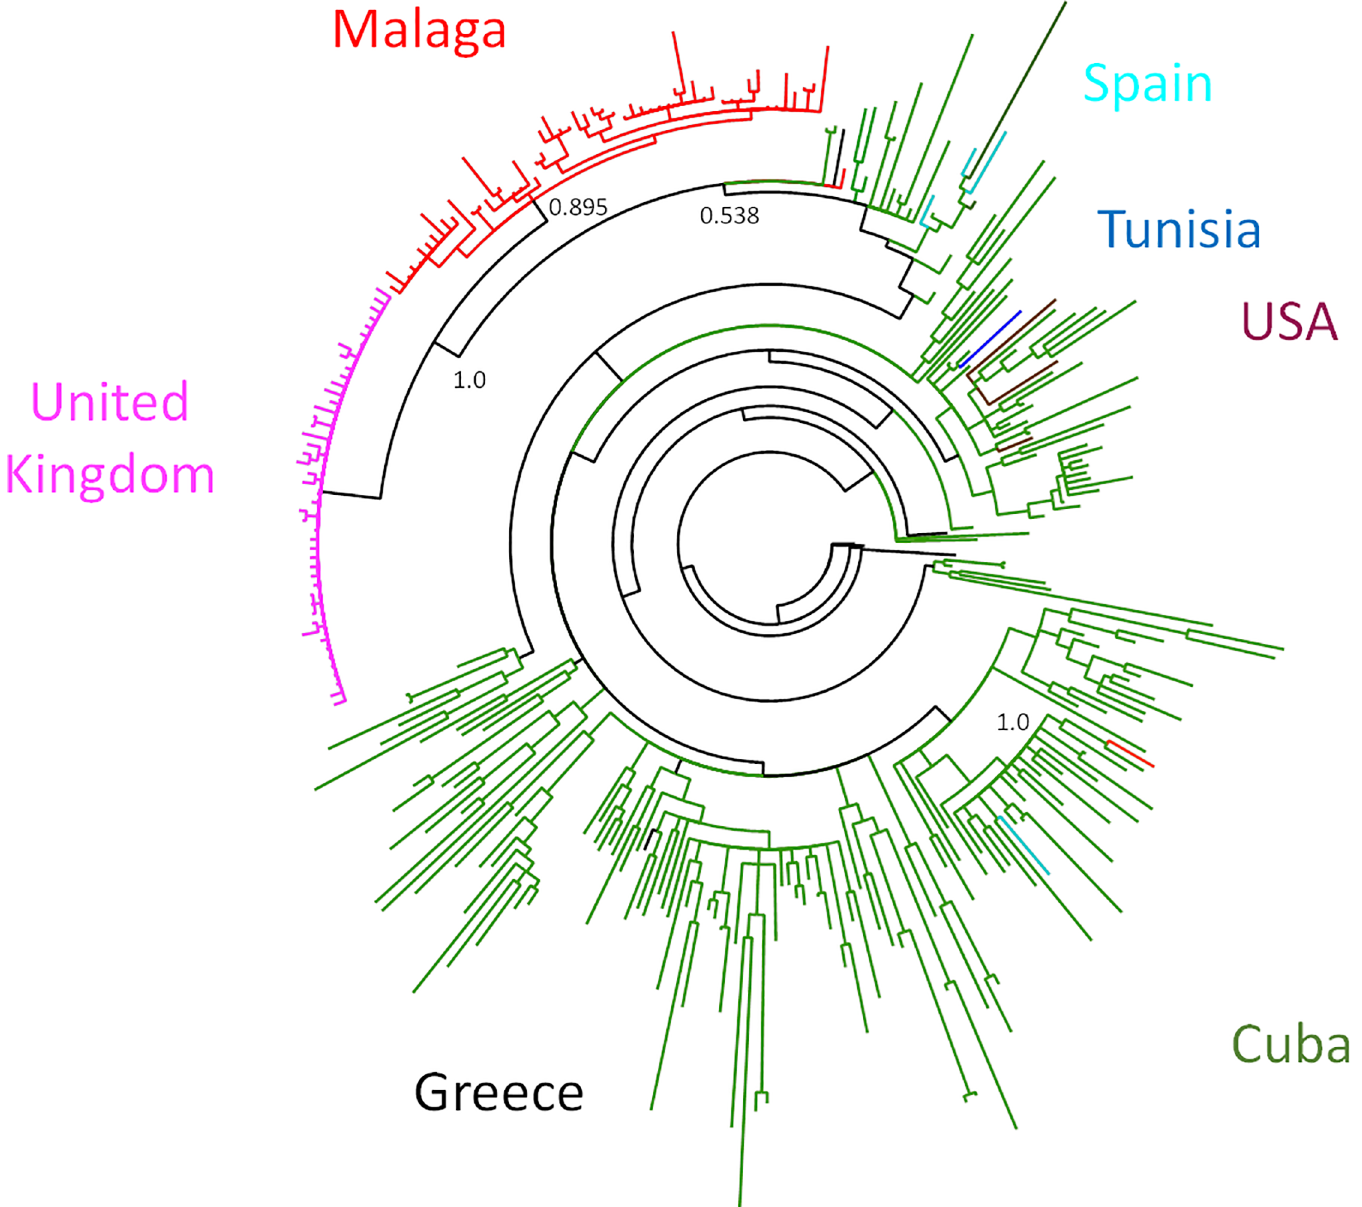
Fig 2. Bayesianmaximum clade credibility phylogenetic tree inferred by MrBayesv3.2 program showing our CRF19_cpx sequences and another 254 reference sequences from the samevariant retrievedfrom LANL. Each patient from our cohort is representedin red by their sample ID, while reference sequencesappearin different coloursaccordingto the country of sampling(green: Cuba; pink: United Kingdom; turquoise: Spain (other than our cohort); brown: USA; black: Greece; blue: Tunisia). This figure is depictedin detail as a supplementary material ( S2 Fig ). https://doi.org/10.1371/journal.pone.0190544.g002 subclusters of different size (pp (cid:21) 0.9) ( Fig 3, Table 1 ). All these subclusters had also correspon- dence in the ML tree, with one or both of the branch-support measures and thresholds consid- ered ( S3B and S4B Figs ). Finally, the most recent common ancestor (MRCA) of this outbreak was dated at 2009 (2007.5–2010.0, 95% HPD) by the Bayesian skyline growth with a lognormal relaxed molecular clock, selected as reporting the lowest AICM value ( S2 Table ).